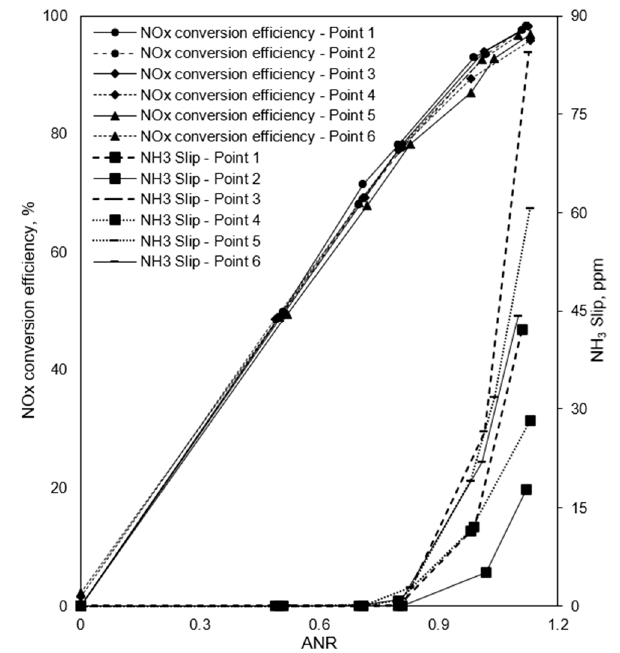
Figure 17. NOx conversion efficiency and NH 3 slip by ANR.